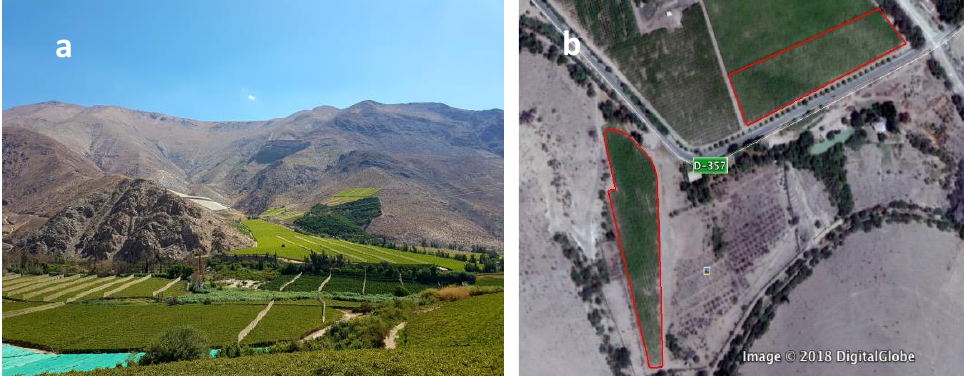
Figure 1. Production of table grapes on slopes and flat areas typical of northern Chile ( a ). The slope (lower left) and flat (top right) vineyards under study ( b ).